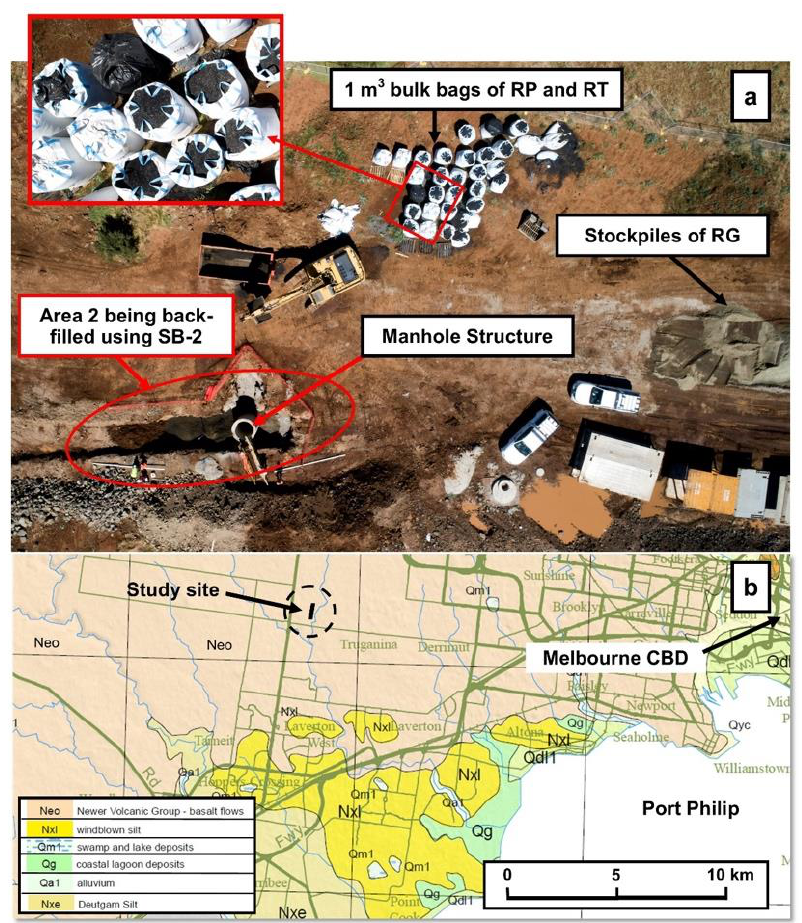
Figure 1. Images of ( a ) the trial site and supplied recycled materials, and ( b ) the geological map of the west of Melbourne and the location of the study site.